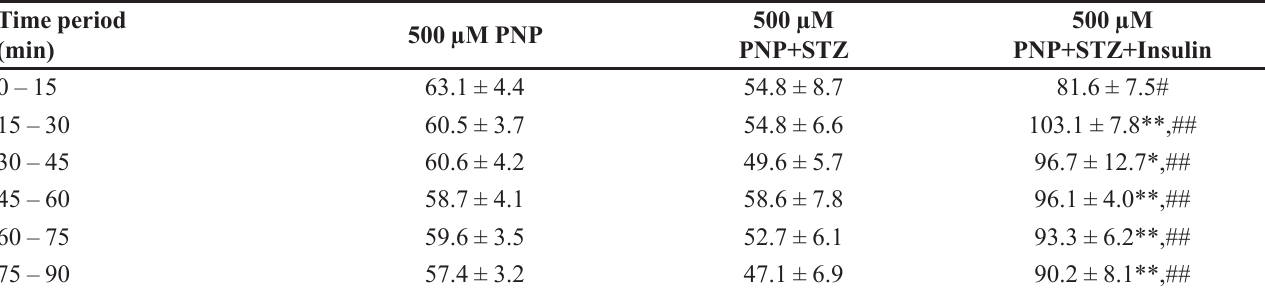
TABLE I - The 15-minute period bile flows (µL/kg/min) in the various experimental groups Time period